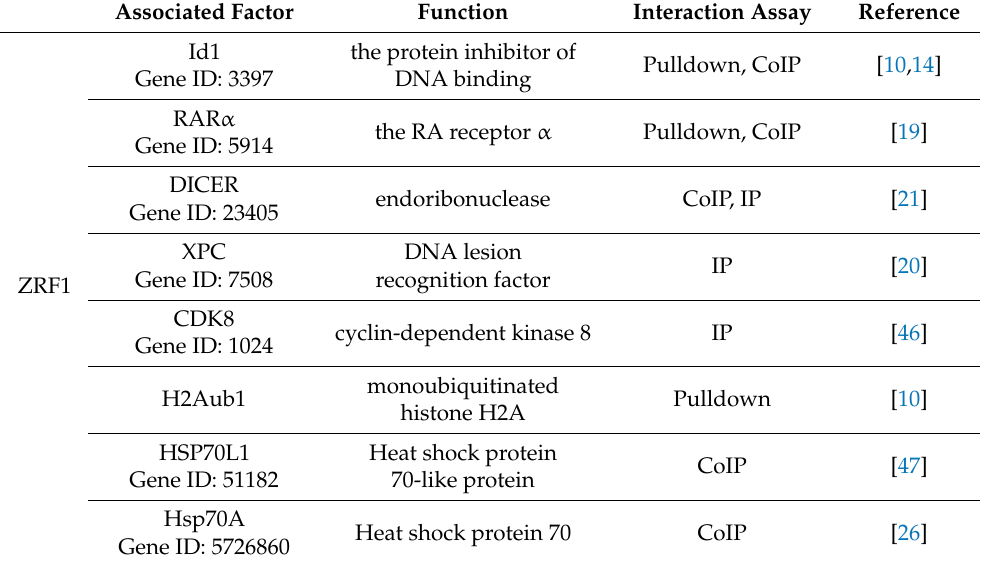
Table 1. List of protein factors reported as associated together with